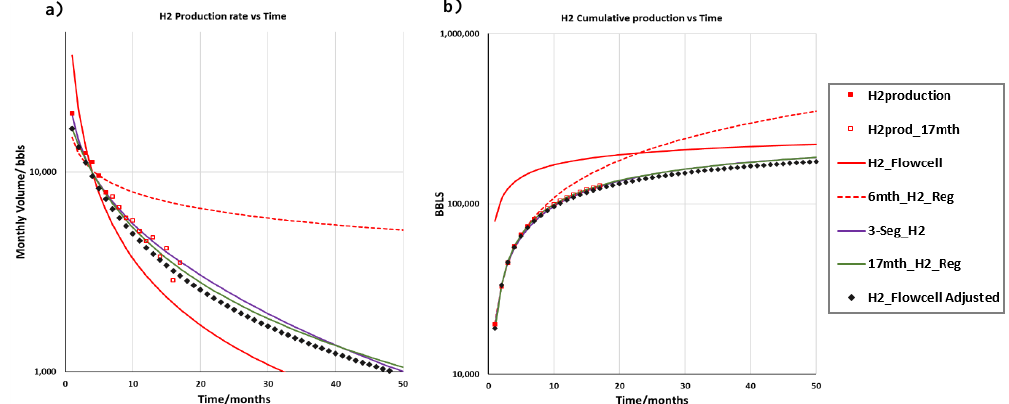
Figure 10. ( a ) Monthly production for H2 well with corresponding forecasts from different methods and the introduction of an adjusted flow-cell forecast making use of the fracture treatment quality factor (TQF) (H2_Flowcell adjusted). ( b ) Cumulative production for H2 well with corresponding forecasts from different methods and the introduction of an adjusted flow-cell forecast making use of the well TQF (H2_flow-cell adjusted).